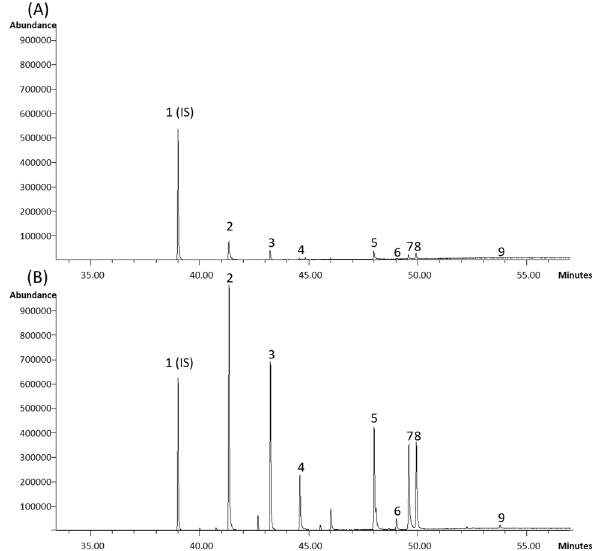
Figure 2. Chromatograms showing the differences in Kava constituents between two Kava samples. ( A ) Kava Fiji; ( B ) Kava Vanuatu. Peaks: (1) internal standard, methyl heptadecanoate; (2) dihydrokavain; (3) kavain; (4)